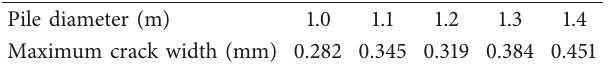
Figure 15: Abutment crack geometry under different pile diameters (mm). Table 7: Maximum crack widths in the abutment backwall for different pile